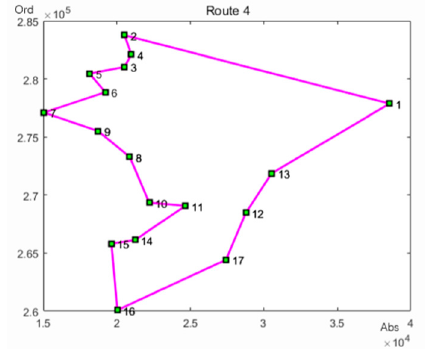
Figure 5. Delivery order of fourth courier.